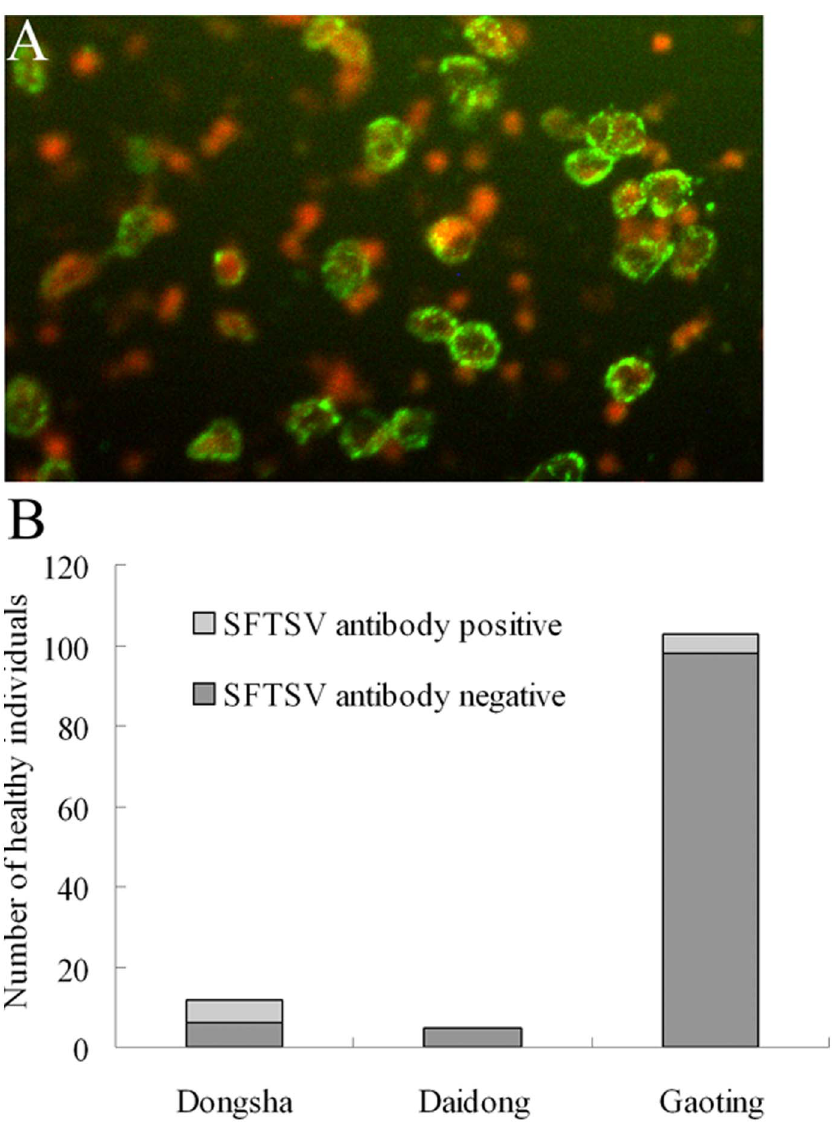
Figure 2. Sero-prevalence of SFTSV in healthy individuals from different villages of Daishan. A: IFA detection of IgG antibodies to SFTSV in healthy individuals. B: ELISA detection result of IgG and IgM antibodies to SFTSV in healthy individuals from different districts of Daishan.